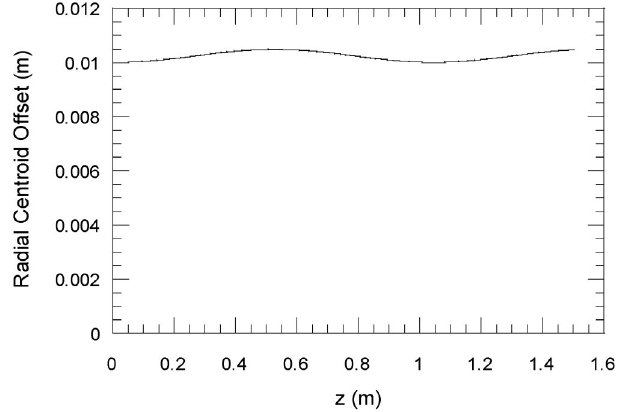
FIG. 7. (Color) Electron-beam slice centroid betatron motion in an ion channel. The red line is the horizontal offset and the blue line is the vertical offset.